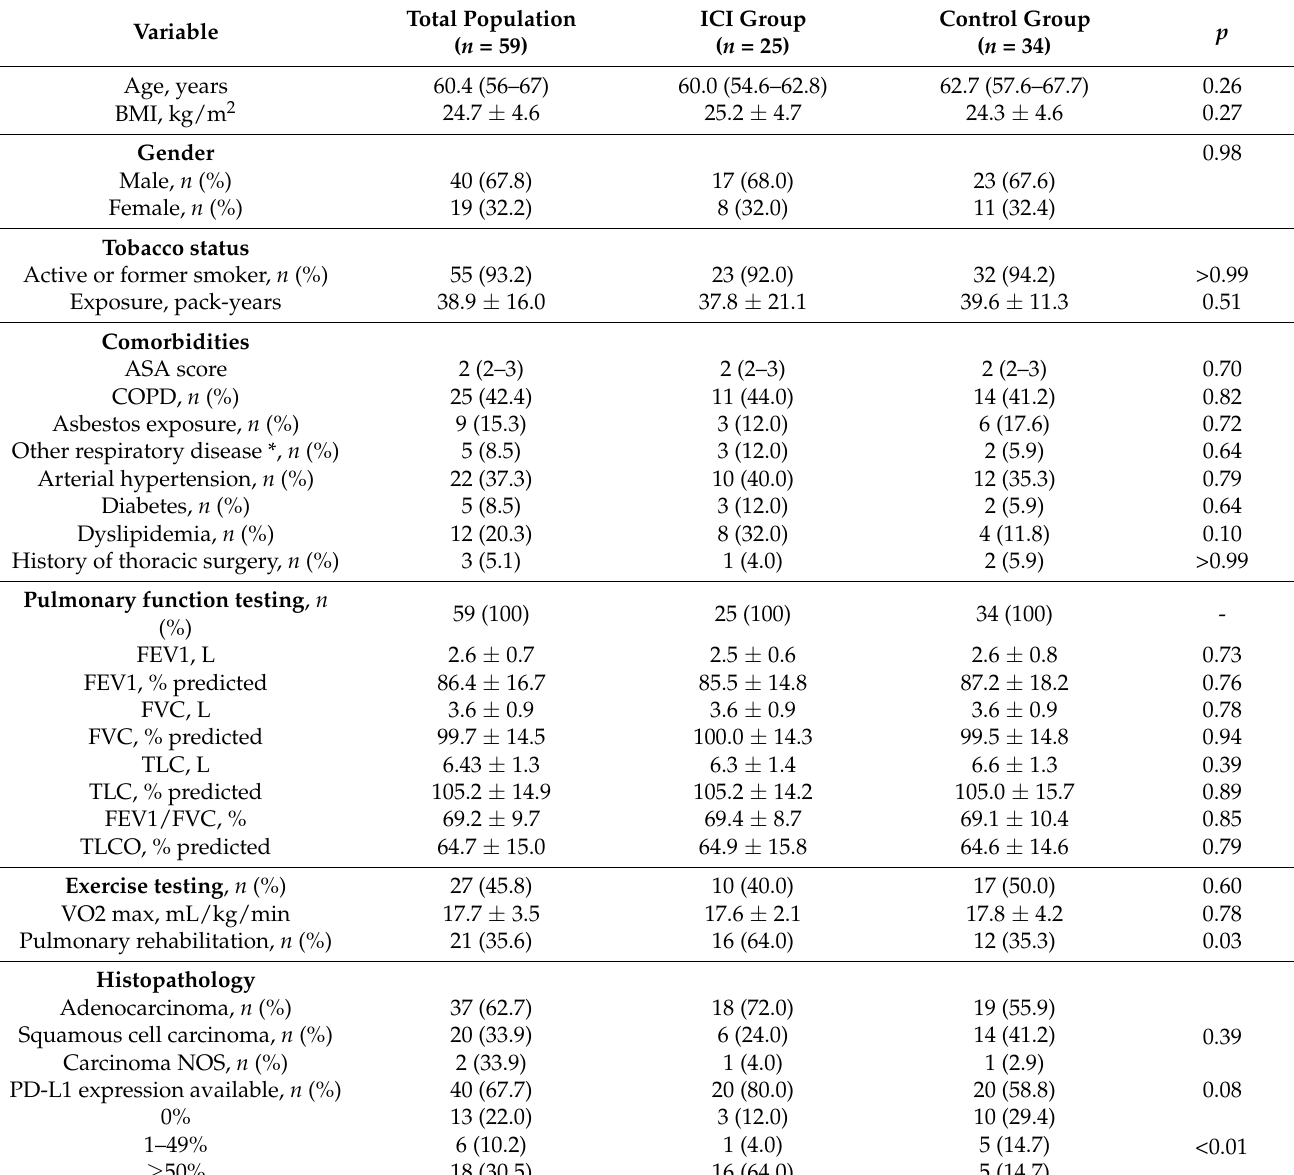
Table 1. Preoperative patient